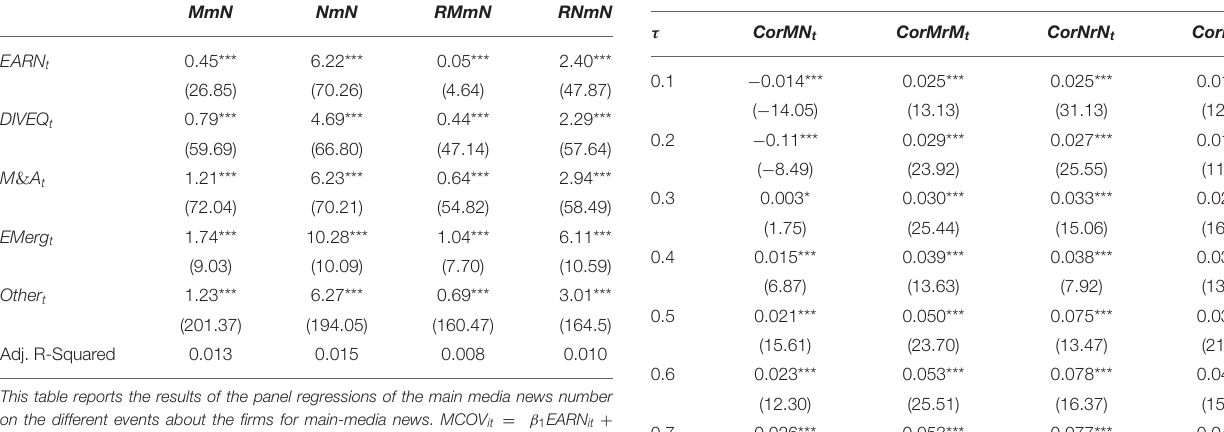
TABLE 10 | Events that drive the coverage of main-media news. TABLE 11 | The results of the quantile regression of the dynamic correlation on the stock market for main-media